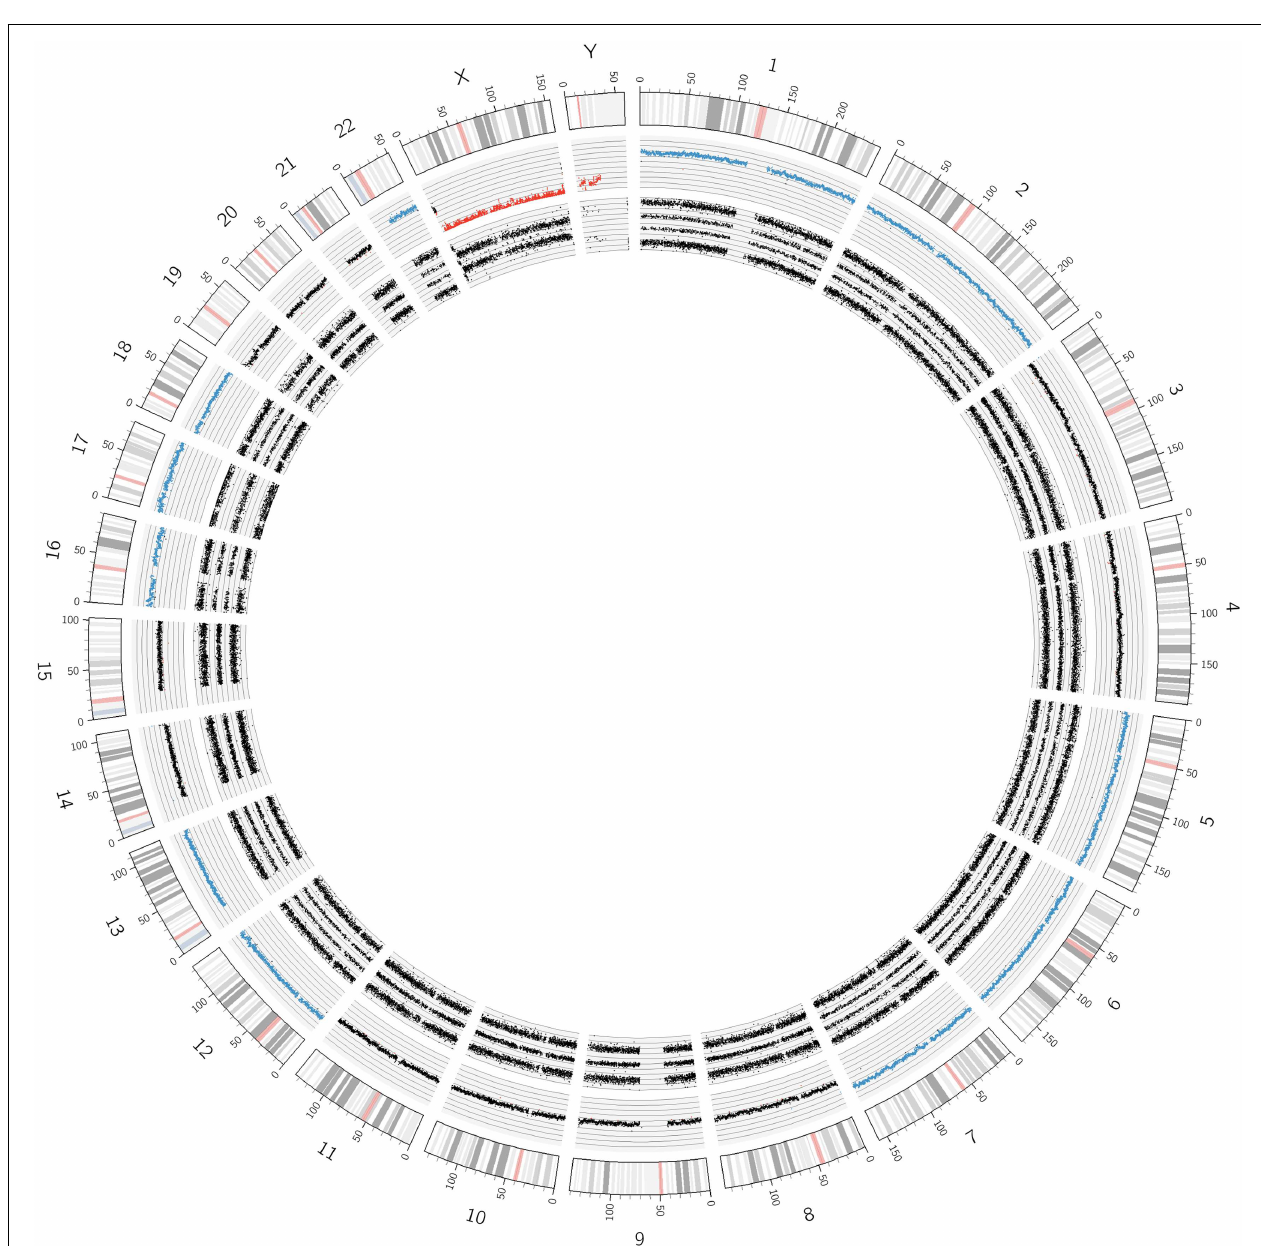
chromosome 17, despite showing three allele peak tracks, is not disomic but tetrasomic, as can be seen by the blue copy number dots. All other autosomes are